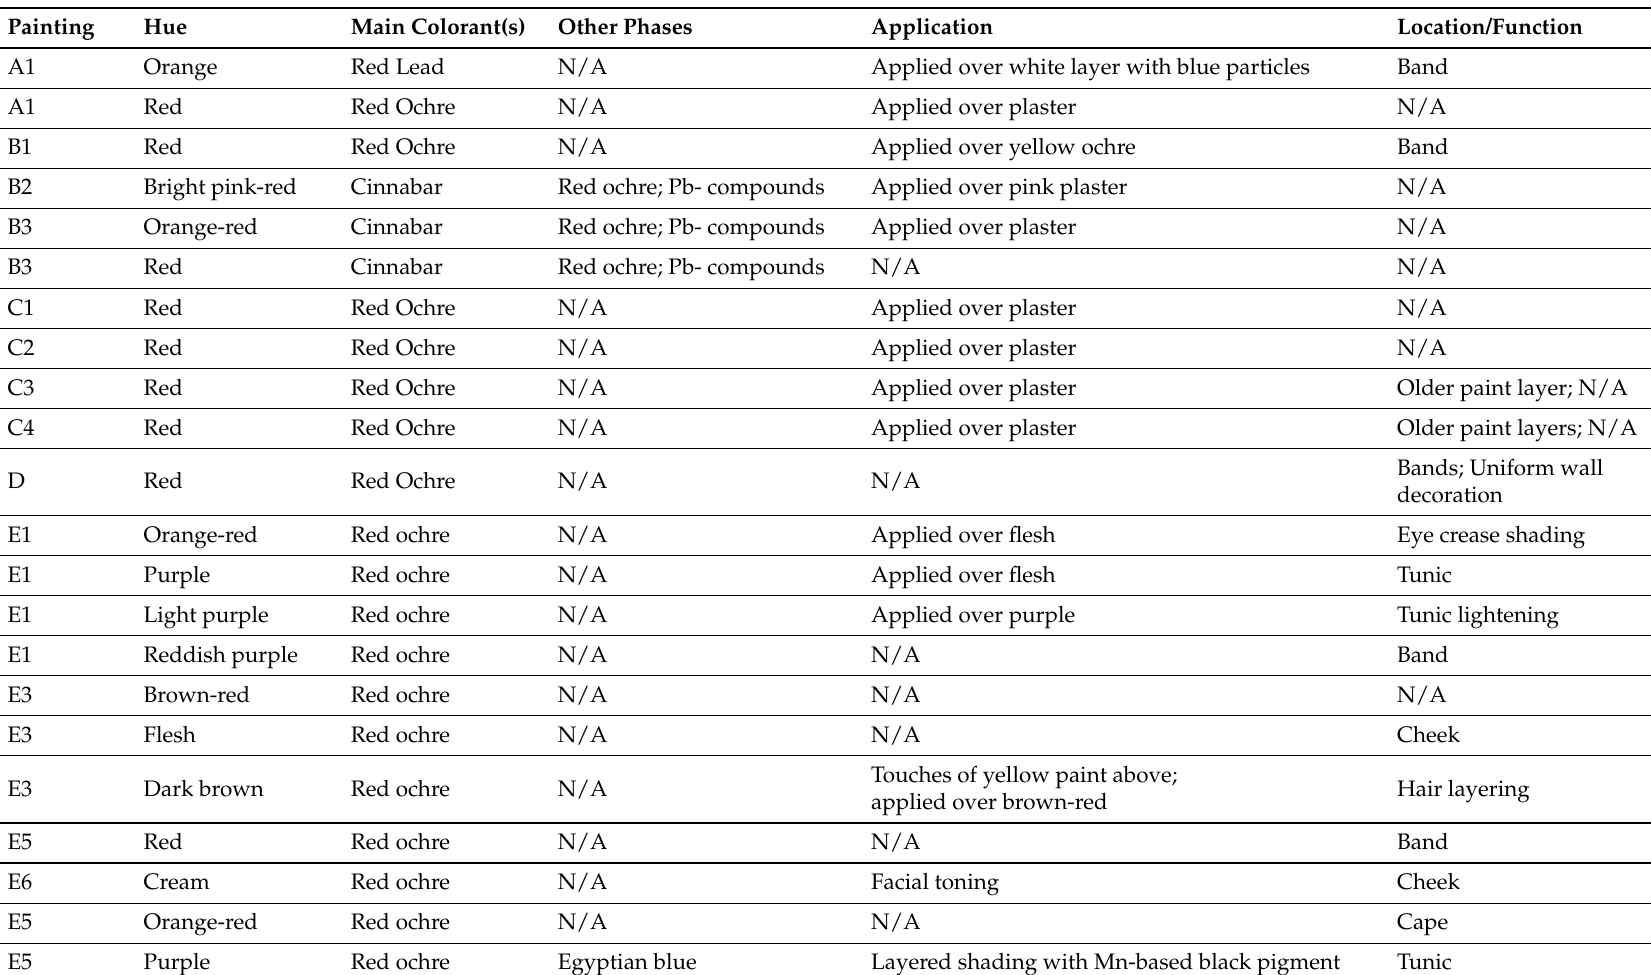
Table A3. Detailed list of the identification and application methodology of red pigments in the Cypriot wall